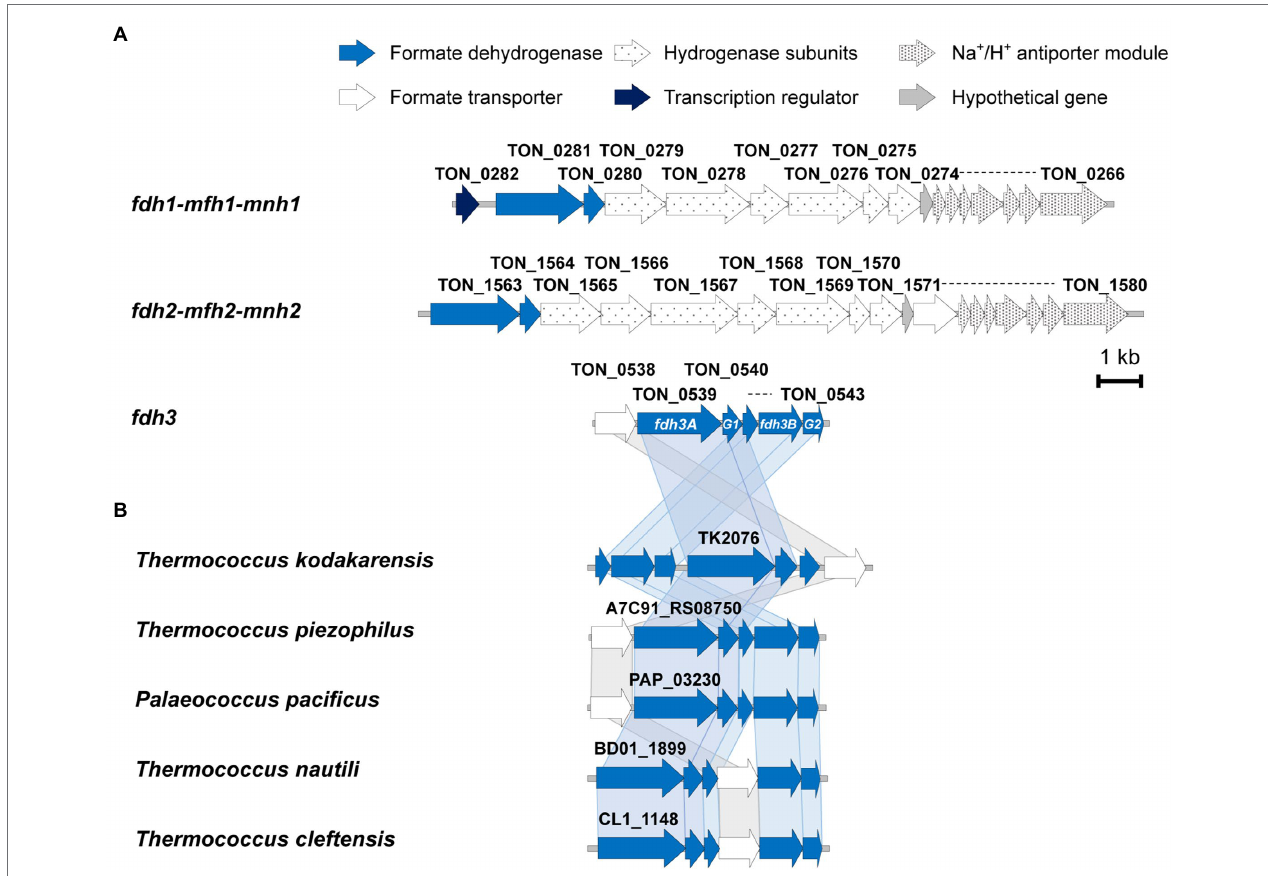
FIGURE 1 | (A) Three formate dehydrogenase gene clusters in Thermococcus onnurineus NA1. The fdh3 gene cluster is composed of six genes, from TON_0538 to TON_0543, transcribed as an operon. On the other hand, the fdh1 and fdh2 gene clusters are composed of three modules: a formate dehydrogenase module, a membrane-associated hydrogenase module, and a Na + /H + antiporter module. (B) Conservation of the fdh3 gene cluster in five other Thermococcales